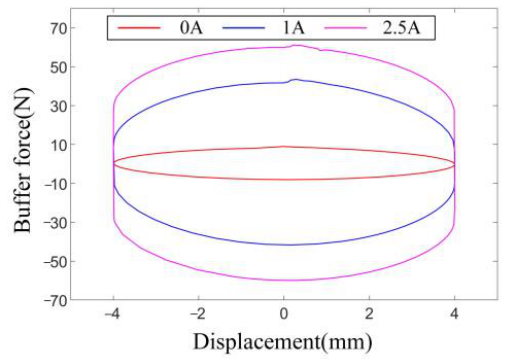
Figure 11. Curve between buffer force and displacement of the VSB.